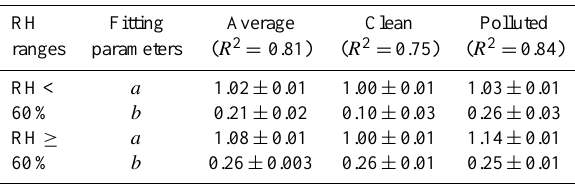
Table 2. The polynomial segment fitting parameter results of f